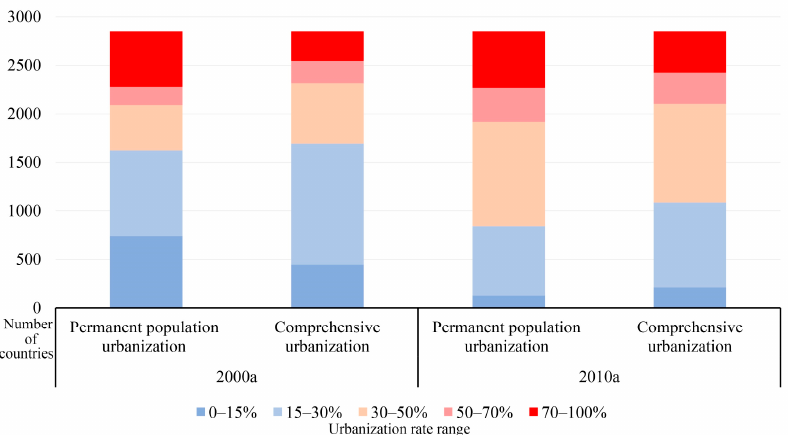
Figure 4. Number of counties with permanent population urbanization and comprehensive urban- ization in different urbanization rates.